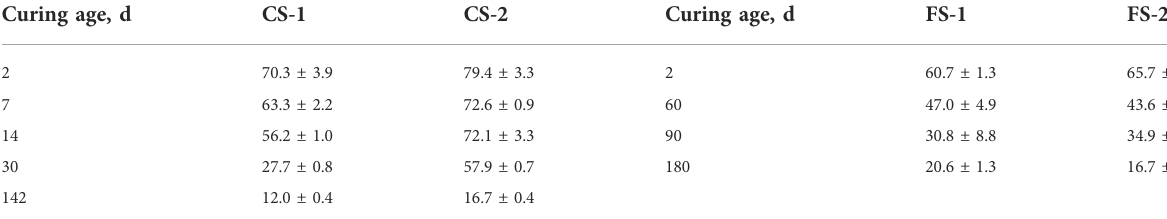
TABLE 2 Compressive strength of slurries cured under 200 ° C and 50 MPa (Pang et al., 2021; Liu et al., 2022), MPa.